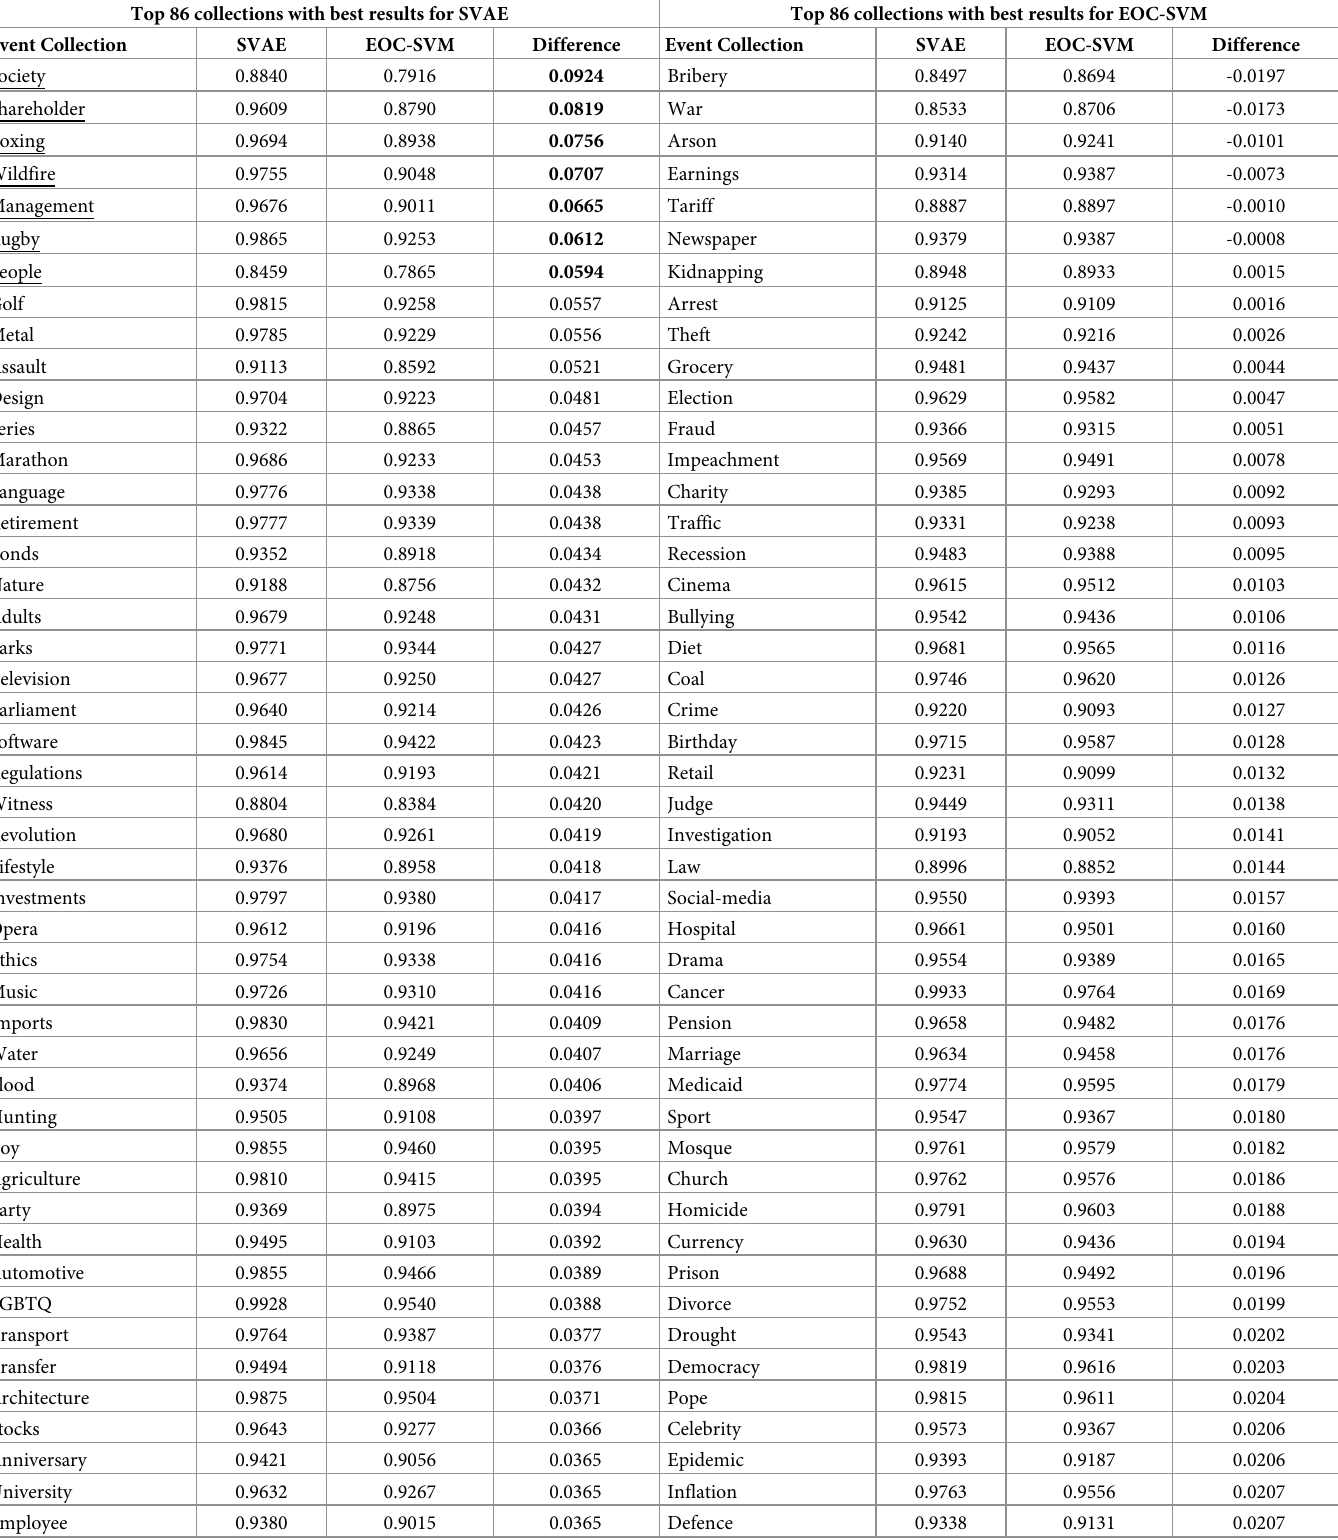
Table 1. F 1 -Score values for 172 event collections to compare SVAE and EOC-SVM sensor learning methods. Top 86 collections with best results for SVAE Top 86 collections with best results for